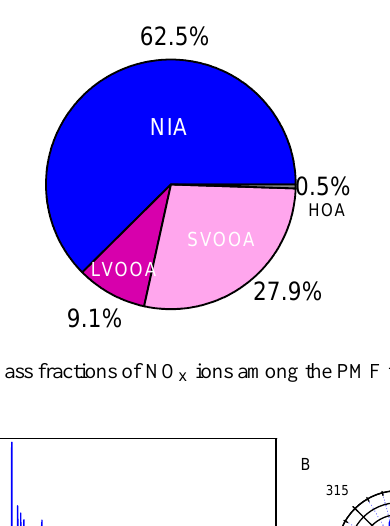
ions among the PMF factors. 12 x